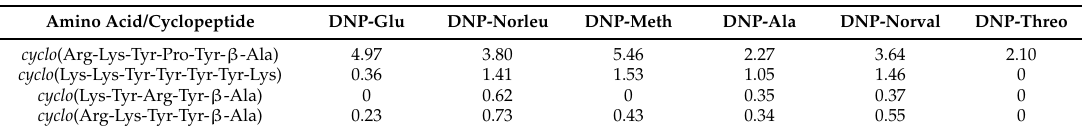
Table 3. Resolution factors R s of DNP-amino acids on cyclopeptides of varying ring size by CE (conditions as in Figure 6) [49].